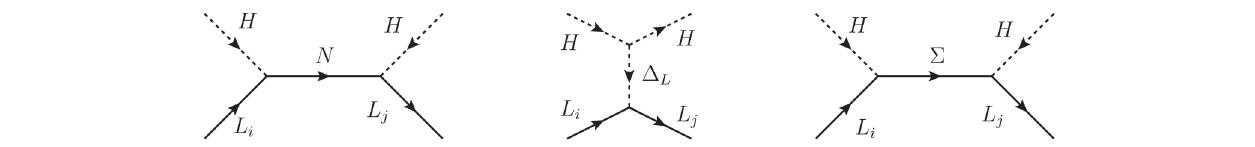
FIGURE 2 | Tree level realization of the Weinberg operators O 1 , O 3 and O 4 . From left to right, the intermediate states are: singlet fermion N , scalar triplet 1 L and fermion triplet 6 fields.